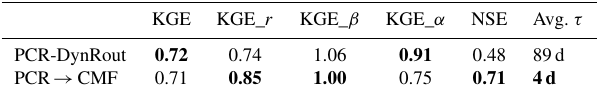
Table 1. Assessment of performance of PCR-DynRout and PCR → CMF runs at Óbidos; the bold values indicate better per- formance. KGE KGE_ r KGE_ β KGE_ α NSE Avg. τ PCR-DynRout